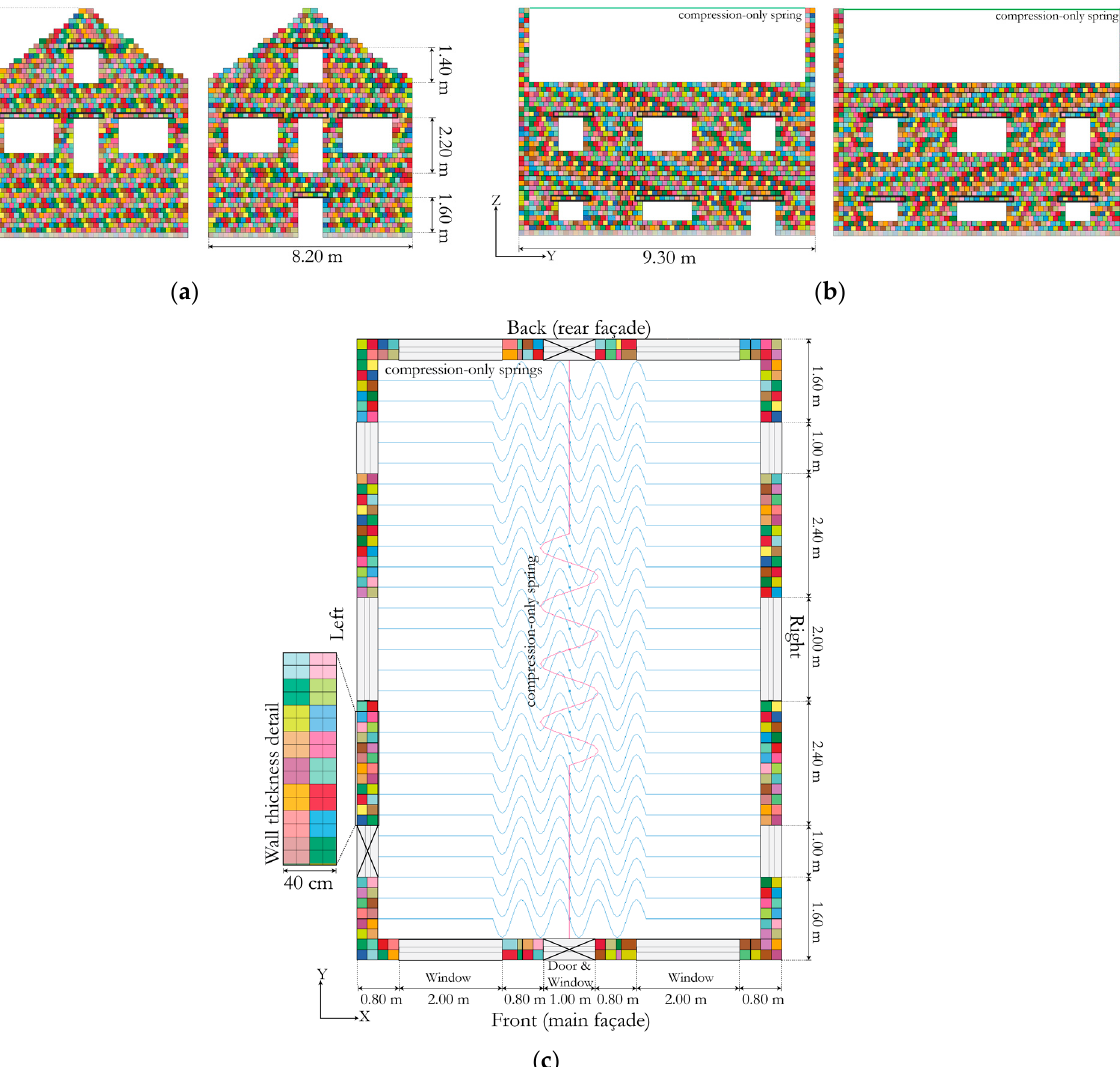
Figure 5. Dimensions of Building 3 and details of the modeling in the LS-DYNA environment: ( a ) elevation view showing the front (main façade) and back (rear façade) showing the gable end walls; ( b ) elevation view showing the left and right walls; ( c ) plan view of the building and position of compression-only springs (left inset) wall thickness detail.